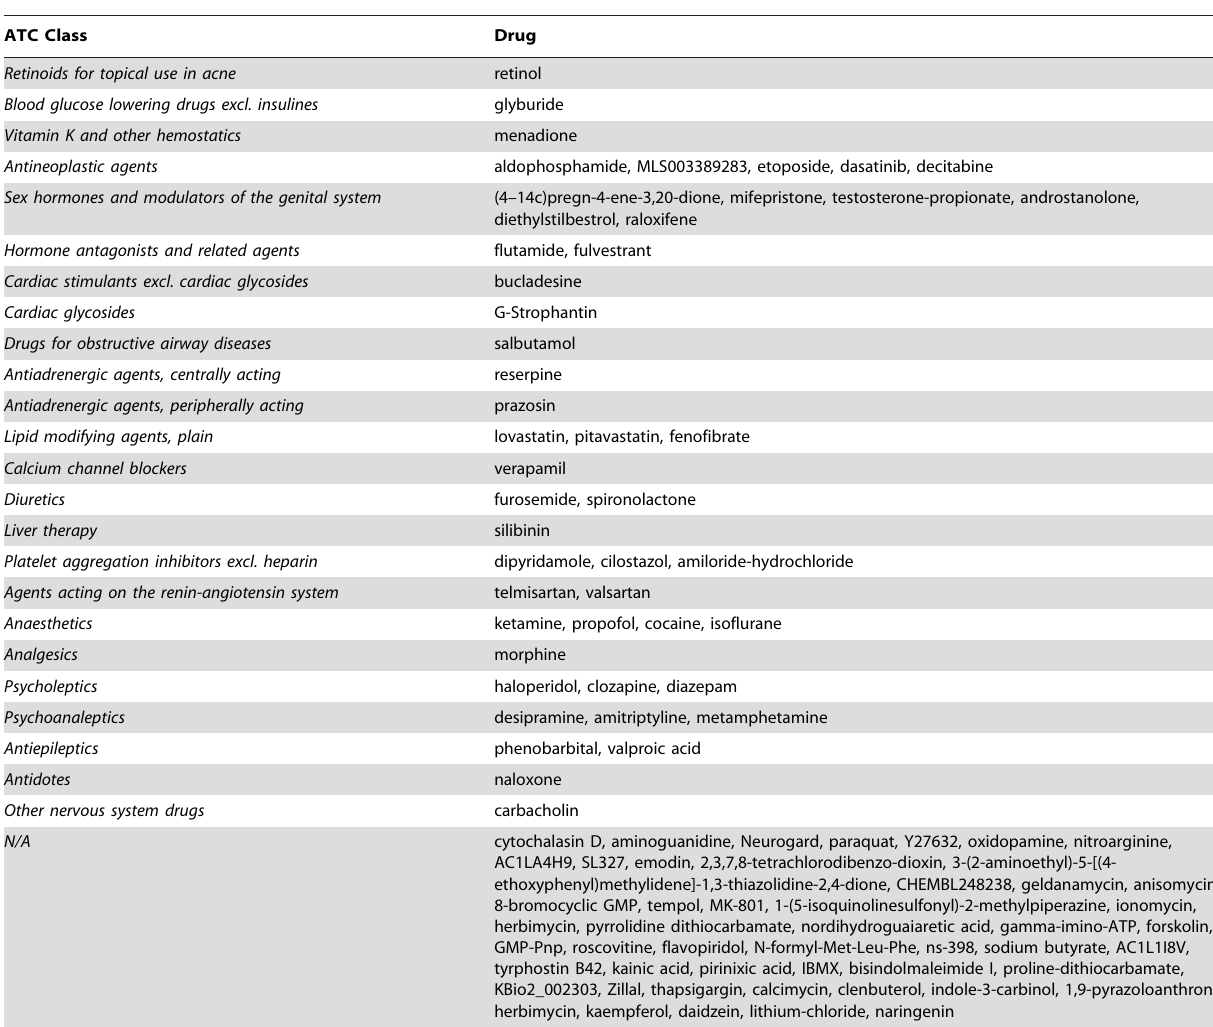
Table 8. Drug candidates unassociated with